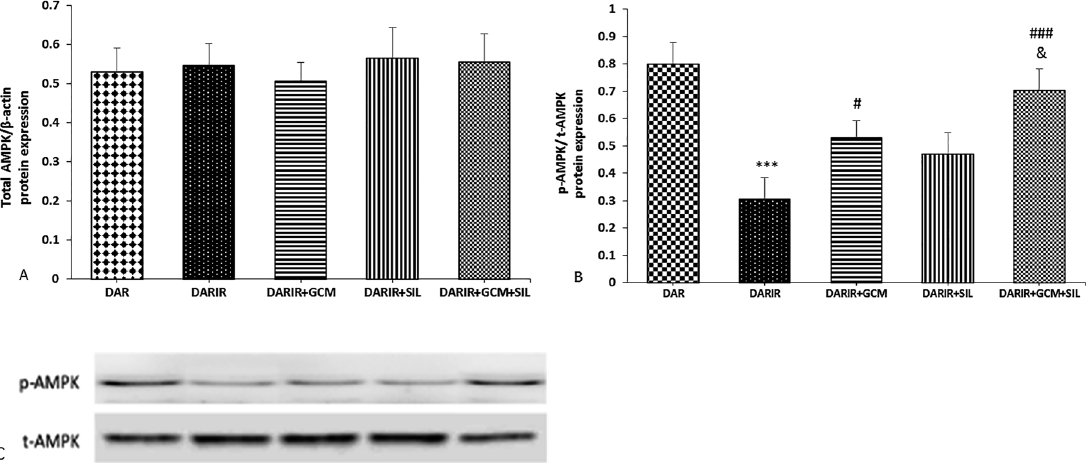
Figure 5: AMPK protein expression in liver tissue. (A) total-AMPK (t-AMPK); (B) phosphorylated-AMPK (p-AMPK); and (C) representative immunoblots. AMPK,AMP-activatedproteinkinase.Thedata wasexpressedasmean ± SD.N=6foreachgroup.***p<0.001 ascomparedwith DAR group; #p<0.05, and ###p<0.001 as compared with DARIR group. & p<0.05 as compared with DARIR + SIL group. DAR, diabetic aged rat; DARIR, diabetic aged rat subjected to ischemia-reperfusion; GCM, ginsenoside compound-Mc1; SIL,